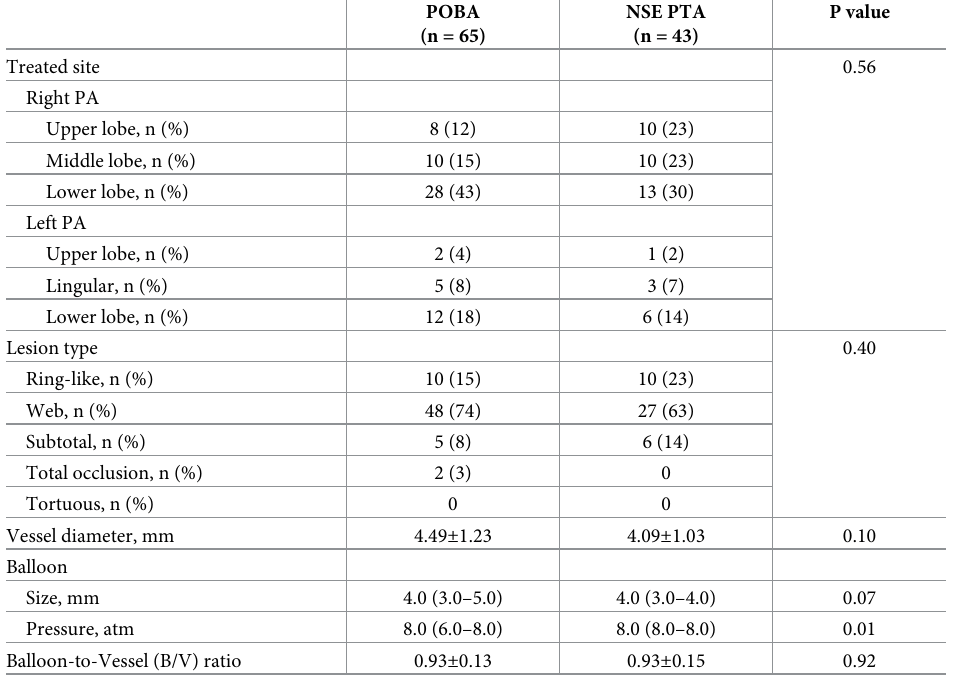
Table 2. Procedure